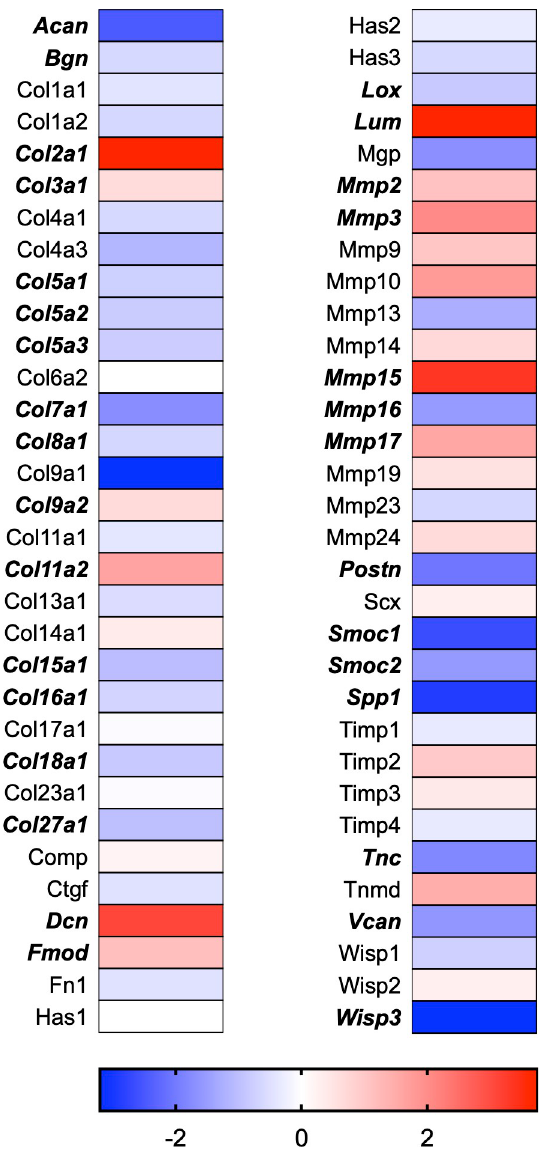
Fig 3. ECM and tenogenic markers heat map. Bold text indicates significantly altered gene